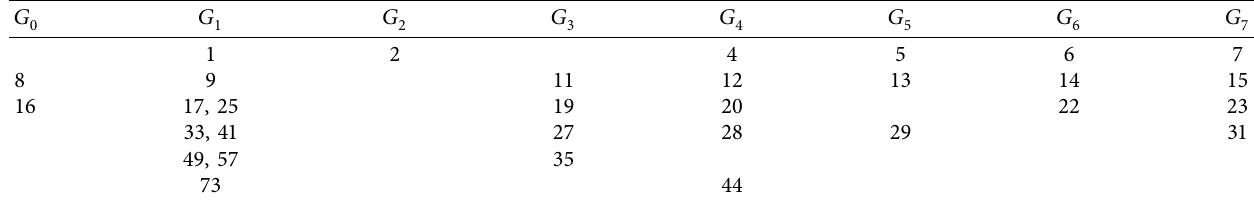
Figure 5: The star graph (a) S and tree (b) T with second hyper-Zagreb index values. 6 Table 2: The first Gourava index values which do not